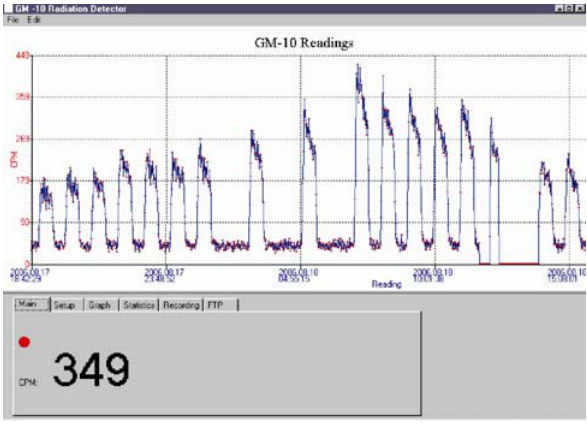
Fig 7. Outdoor radon progeny volumetric activity in air during 24 hours